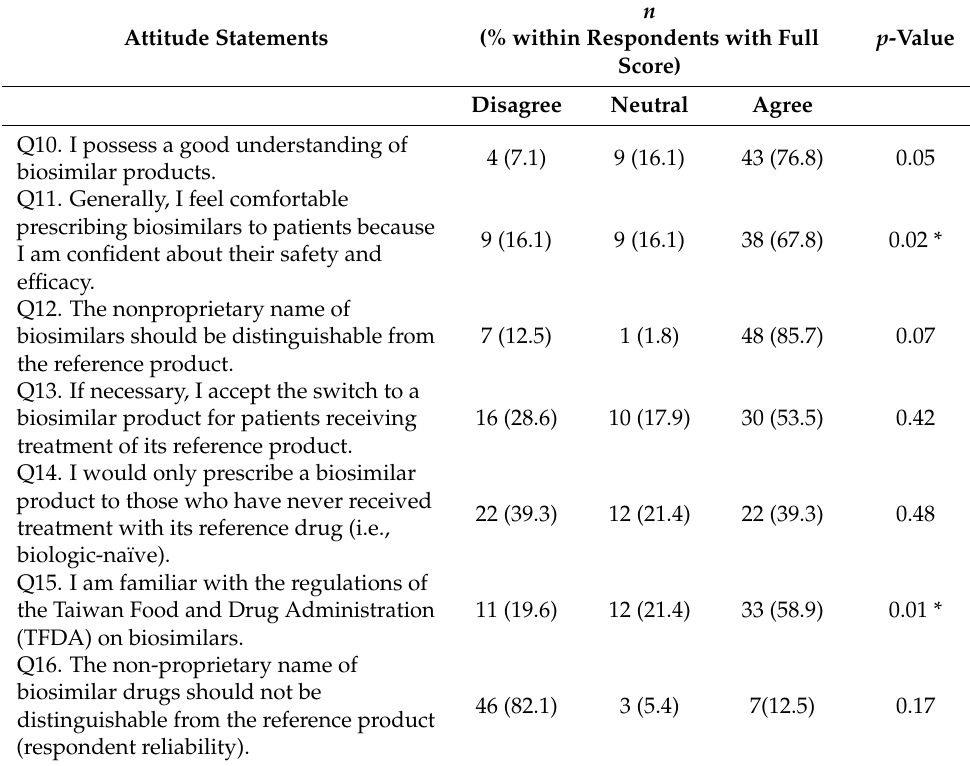
Table 3. The association between attitude statements and respondents’